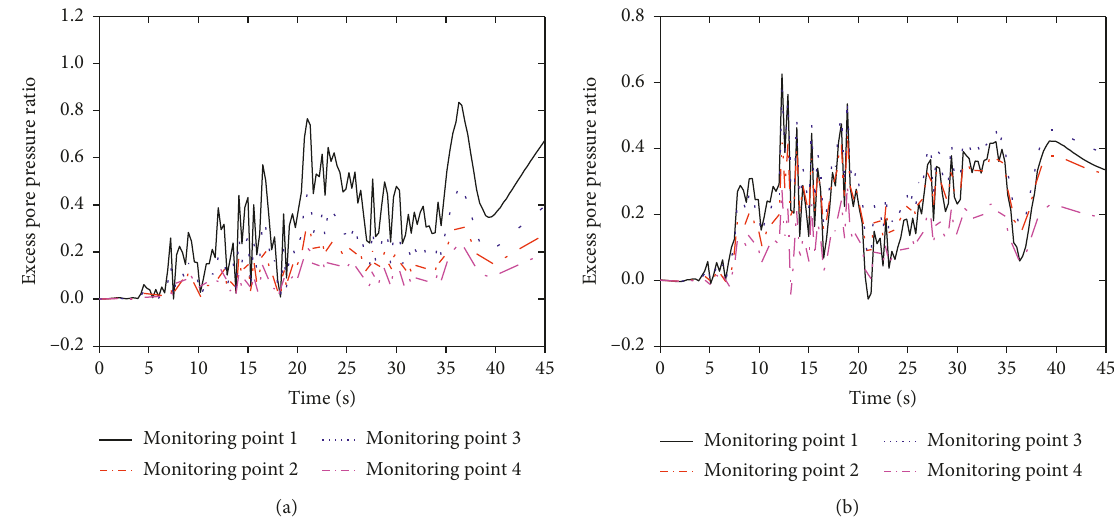
Figure 20: Excess pore water pressure ratios of the saline soil before and after strengthening. (a) Solidified subgrade. (b) Unsolidified